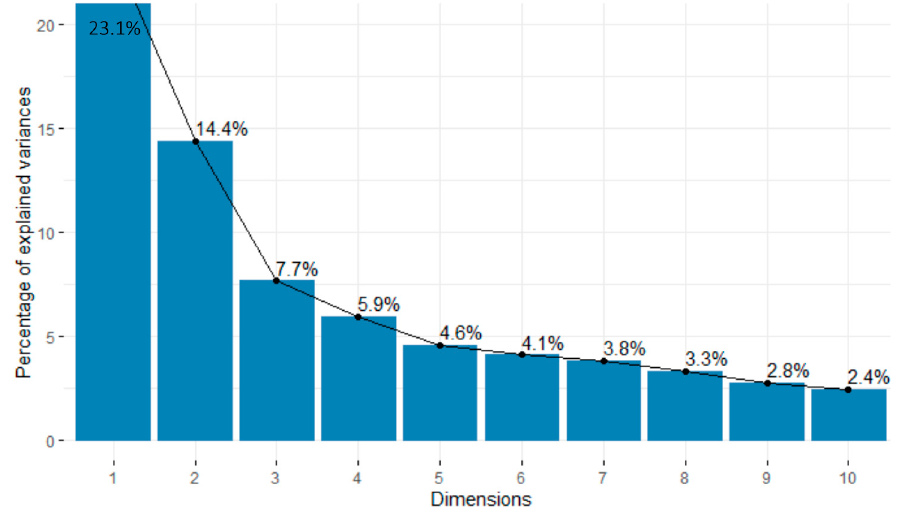
Figure 3. Screeplot for bottom teams.